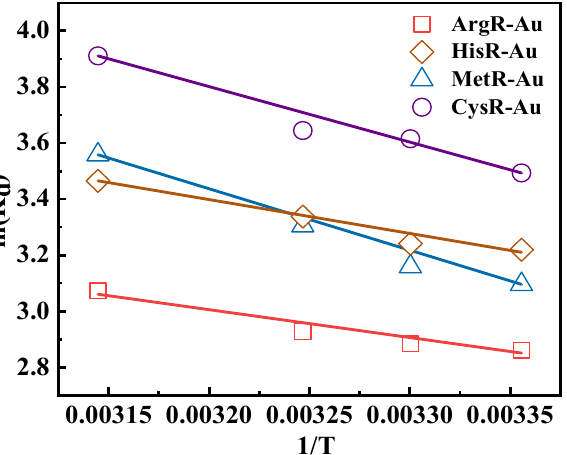
Figure 5. Van’t Hoff plots of amino acid resins for Au(III) ion adsorption (C 0 = 100 mg/L, adsorbent mass = 10 mg, volume = 10 mL, pH = 2, contact time = 24 h).